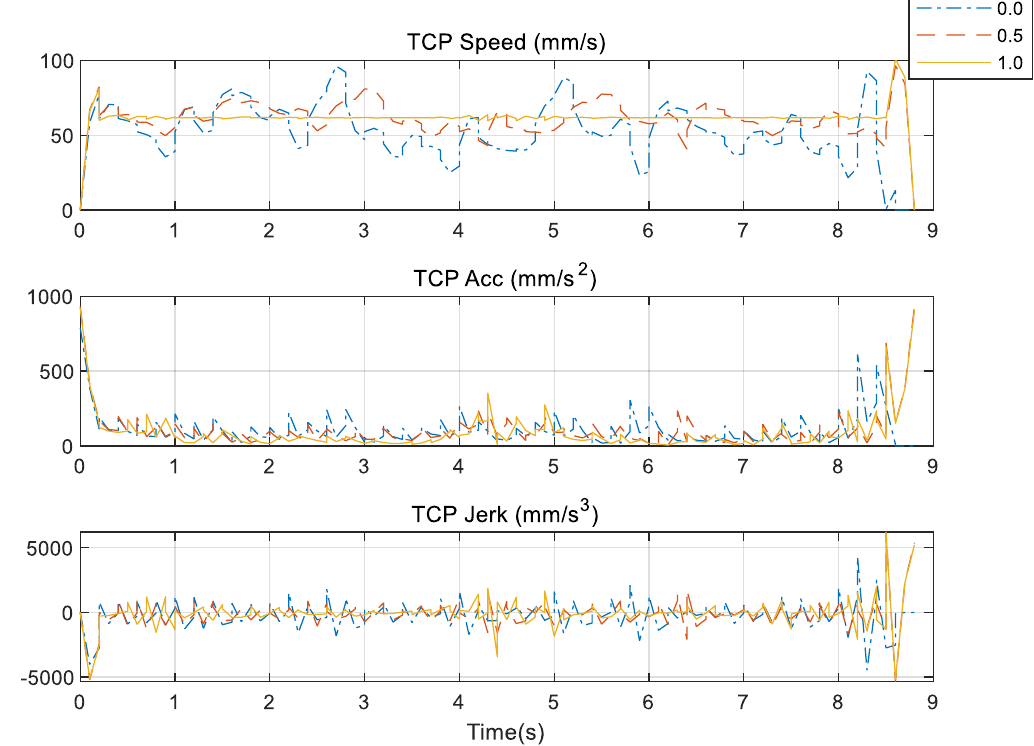
Figure 23. TCP speed, acceleration, and jerk in trajectory planned using 43 points.